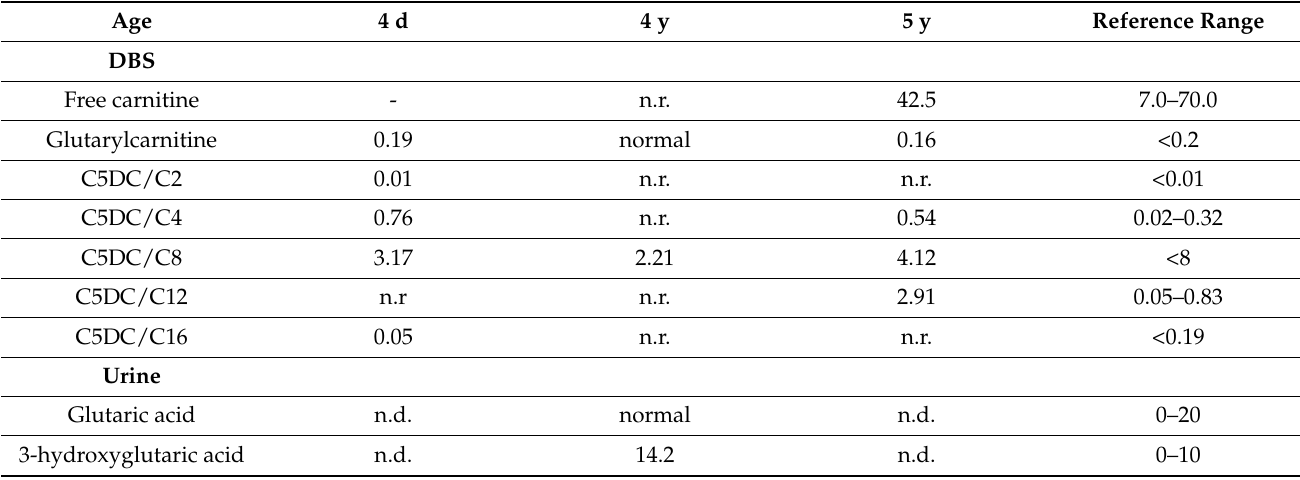
Table 3. Laboratory results of patient 3. Free carnitine and glutaryl-carnitine are in µ mol/L; organic acids are in mmol/mol creatinine. n.r. = not reported; n.d. = not done.